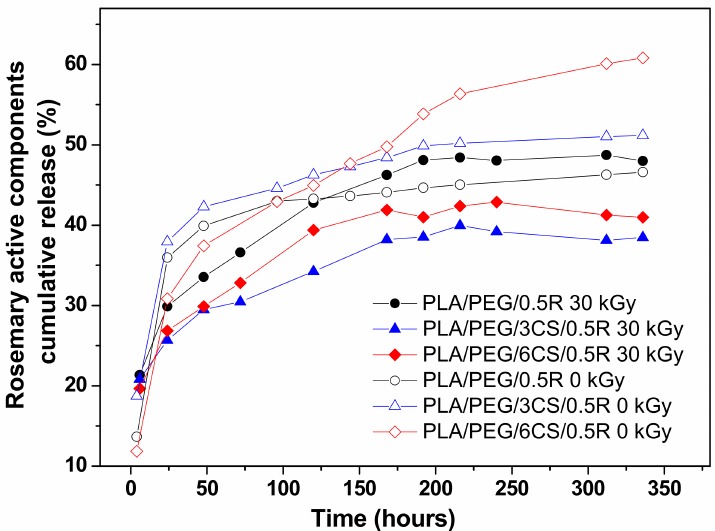
Figure 13. Comparative migration profiles of the bioactive compounds of R from irradiated and non-irradiated PLA/PEG/R and PLA/PEG/CS/R